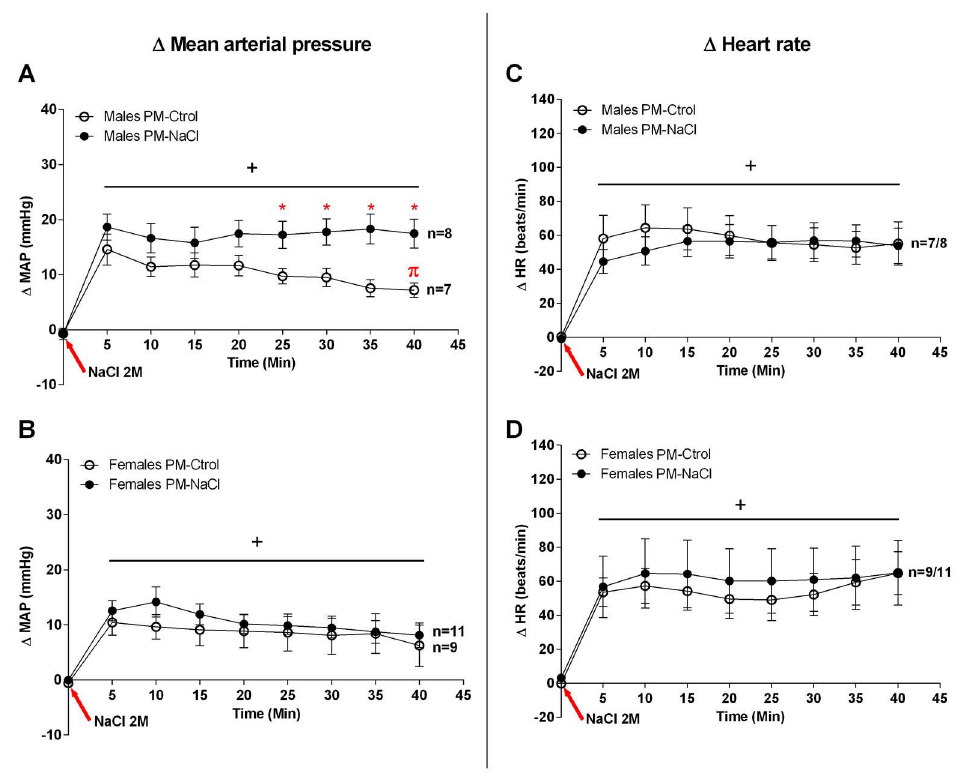
Figure 2. Sodium programming effect on mean blood pressure (MAP) and heart rate (HR) in response to sodium overload (SO). Line graphs show the effect of SO on mean arterial pressure changes (MAP, ( A , B ) panel) and heart rate (HR, ( C , D ) panel) in male (( A , C ) panel) and female rats (( B , D ) panel) of both PM conditions (PM-Ctrol and PM-NaCl). Data are plotted as the changes (Δ) in MAP and HR compared with baseline values obtained 10 min before NaCl 2M injection. Number of animals in each group: Males: PM-Ctrol (n = 7) and PM-NaCl (n = 8); Females PM-Ctrol (n = 9) and PM-NaCl (n = 11). * p < 0.05 compared to PM-Ctrol group at 25, 30, 35 and 40 min after NaCl 2M injection. + p < 0.05 vs. baseline at time zero. π p < 0.05 compared to 5 min of PM-Ctrol (higher point to